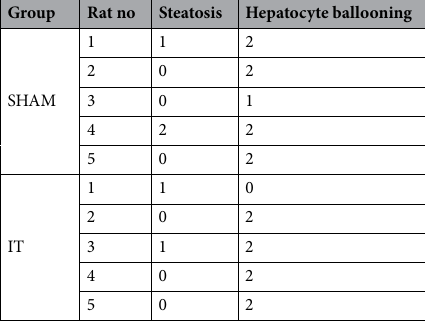
Table 6. Histopathological assessment of Zucker (Crl:ZUC(ORL)-Lepr fa ) rats liver samples collected from animals 12 weeks after ileal transposition (IT) or control (SHAM)